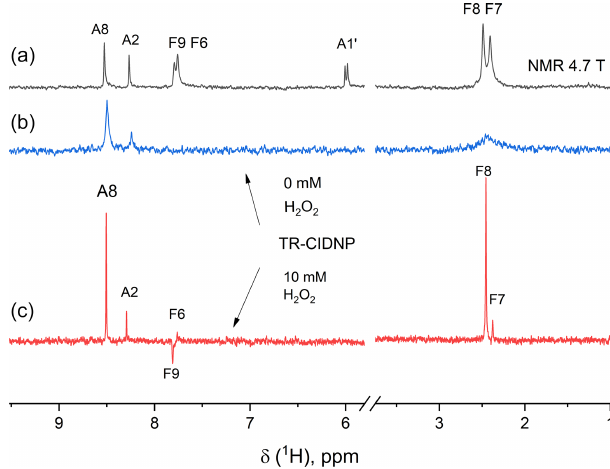
Figure 5. The 200MHz NMR (a) and photo-CIDNP spectra (b, c) of a 0.9mM solution of FAD in D 2 O at pH 3.2 without H 2 O 2 (b) and with 10mM H 2 O 2 (c) taken without delay after a short, single laser pulse. Background magnetization is removed by a saturation pulse sequence applied prior to the short, single laser pulse. Absorp- tive CIDNP signals are detected for the H8 and H2 protons of the adenine moiety in both CIDNP spectra, while for the flavin moiety absorptive signals of the F7- and F8-methyl protons and an emis- sive CIDNP signal of F9 are seen in the geminate spectrum obtained with addition of H 2 O 2 (c)